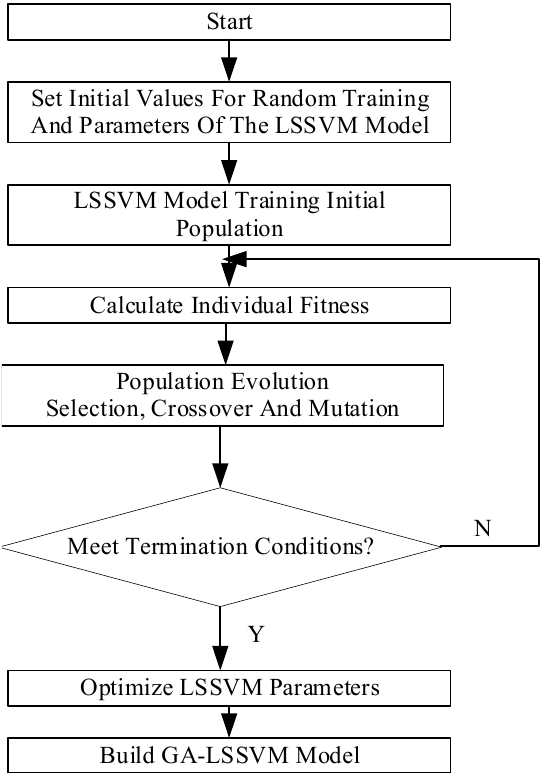
Figure 3. Flow chart of scenario prediction model based on GA–LSSVM.